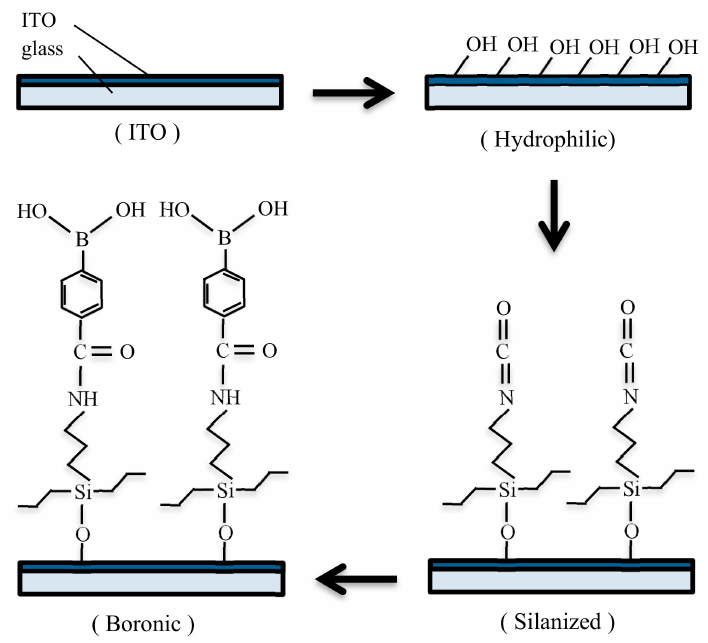
Figure 3. Surface modification for glucose